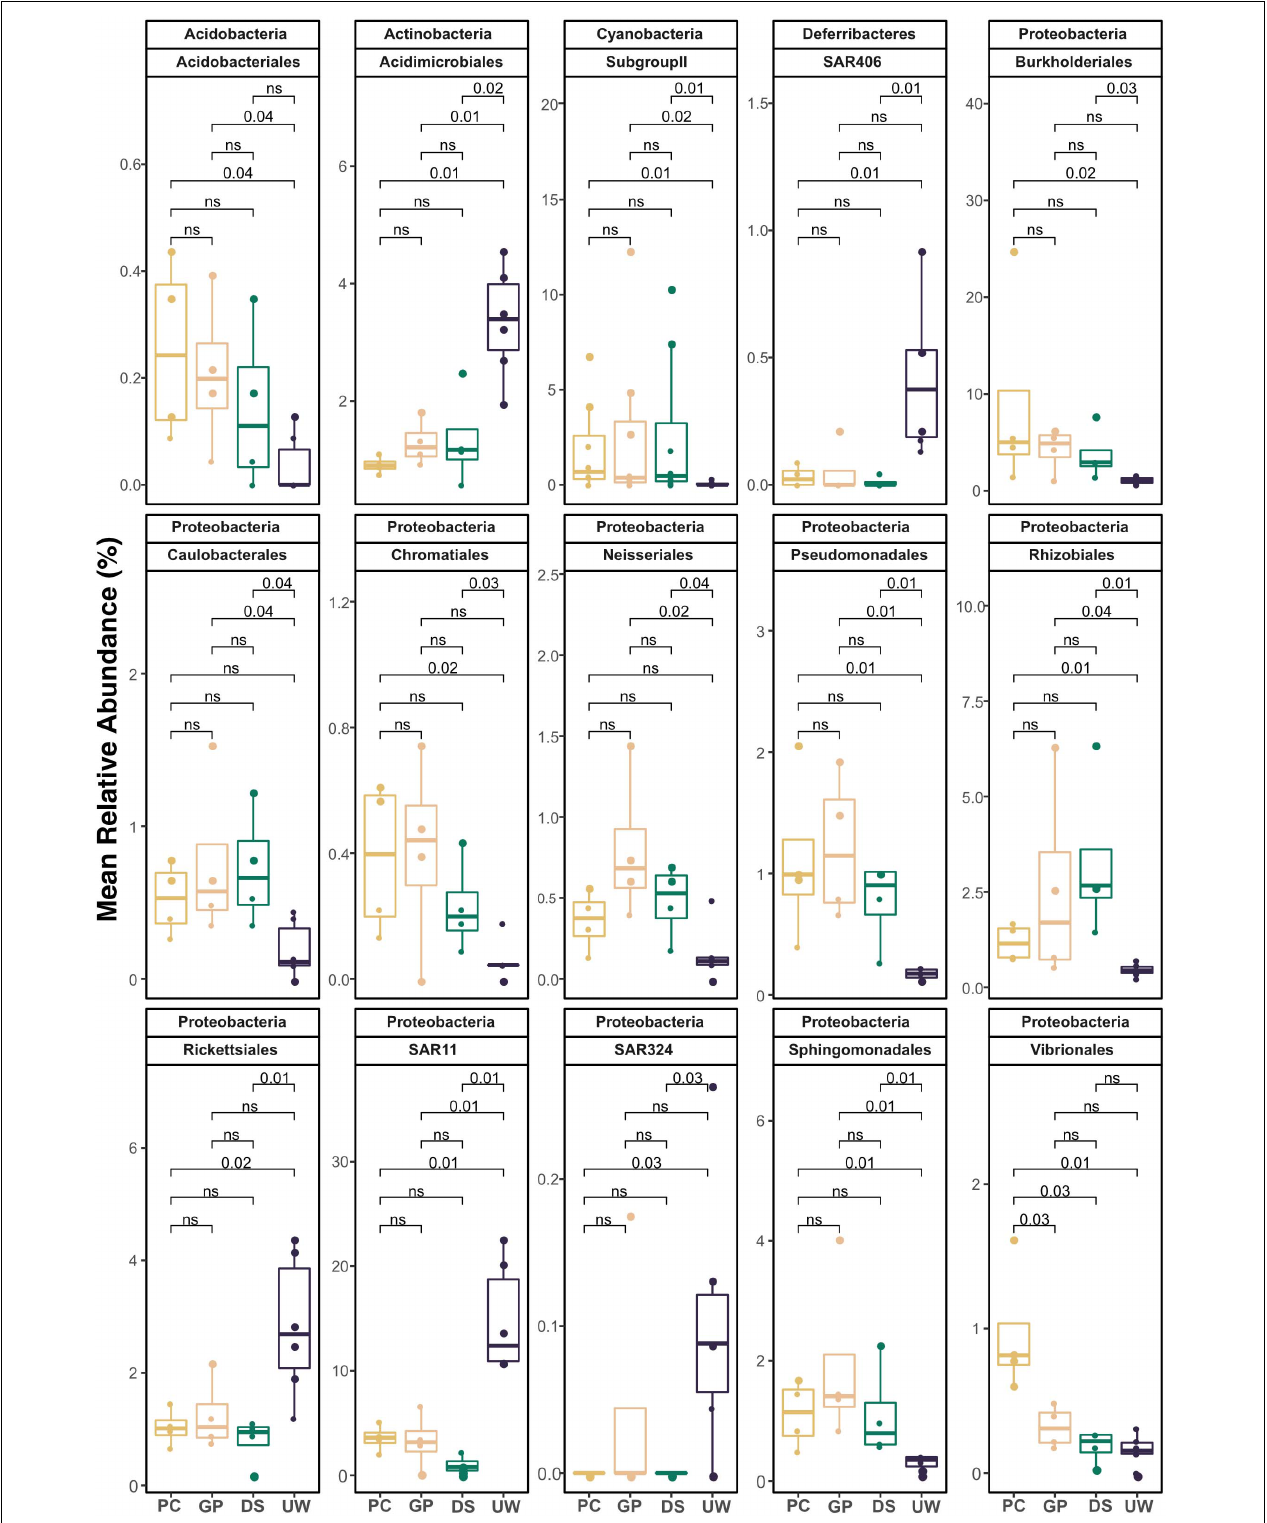
FIGURE 4 | Mean percentage relative abundance of pooled data from summer, winter, SML and UW samples, collected by either PC, DS, GP, and UW during high biological enrichment in the SML. Taxonomic assignments are listed as phylum followed by order. Only orders with p < 0.05, calculated using Wilcoxon signed rank test, are shown. ns = not